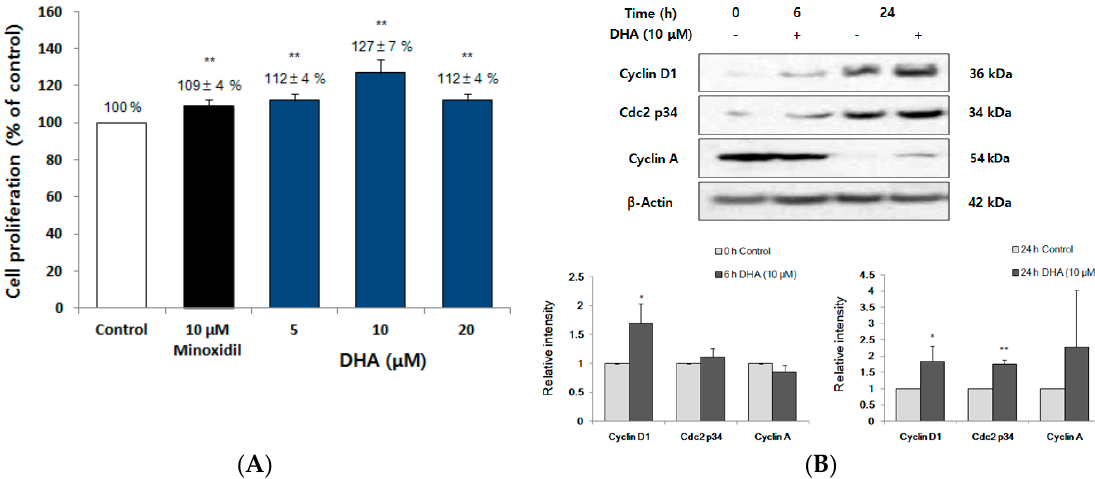
Figure 6. The effect of DHA on the proliferation of DPC. ( A ) Cell proliferation of DPC exposed to DHA (5, 10 and 20 µ M, 72 h) is shown at 72 h. Minoxidil was used as a positive control. Data are presented as the mean ± SD. ** p < 0.01 vs. vehicle-treated control. ( B ) Immunoblot analysis of cell cycle-associated proteins on DPC stimulated in the presence or absence of 10 µ M DHA. The cell lysate was analyzed by immunoblot using anti-cyclin D1, cyclin A and Cdc2 p34 antibodies. The graph represents the quantitative level of the proteins. * p < 0.05, ** p < 0.01 vs. vehicle-treated control.